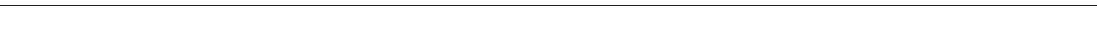
Fig. 4 Key gene families related to the ecdysone signal pathway in the L. vannamei genome. a Picture of shrimp and its shed exoskeleton. Schematic diagrams below the picture show the changes of the epidermis (ep: epicuticle, ex: exocuticle, en: endocuticle, ed: epidermis, ba: basement membrane) during the molting cycle. The molting cycle can be divided into eight stages: Intermolt (C) stage, Premolt stages (D0 – D4), and Postmolt stages (P1 – P2). b The shrimp ecdysone signal pathway. Expanded gene families are highlighted in red. c Distribution pattern of the expanded gene families in shrimp ecdysone signal pathway and comparison with other arthropods. d Expression patterns of the expanded gene family genes at the different molting stages of L. vannamei . The overall expression trends in different molting stages are shown in the right. e Phylogenetic analysis of the CHH family based on CDS sequences containing full CHH domain, reconstructed using IQ-tree 1.6.2 under TVMe + I + G4 model with ultrafast bootstrap method. Sequences from L. vannamei genome are annotated with circles of various colors to indicate their corresponding scaffold of origin. GenBank sequences of the CHH family from genus Penaeus s.l., Macrobrachium , Homarus , as well as from species Eriocheir sinensis , Discoplax celeste , Daphnia magna and Drosophila melanogaster were incorporated in this analysis. These sequences were annotated in the phylogenetic tree as follows: species name/gene description/accession number. They were classi fi ed into type I, II, and III CHH subfamilies, in which type III CHH consisted of ion transport peptides (ITPs). CHH crustacean